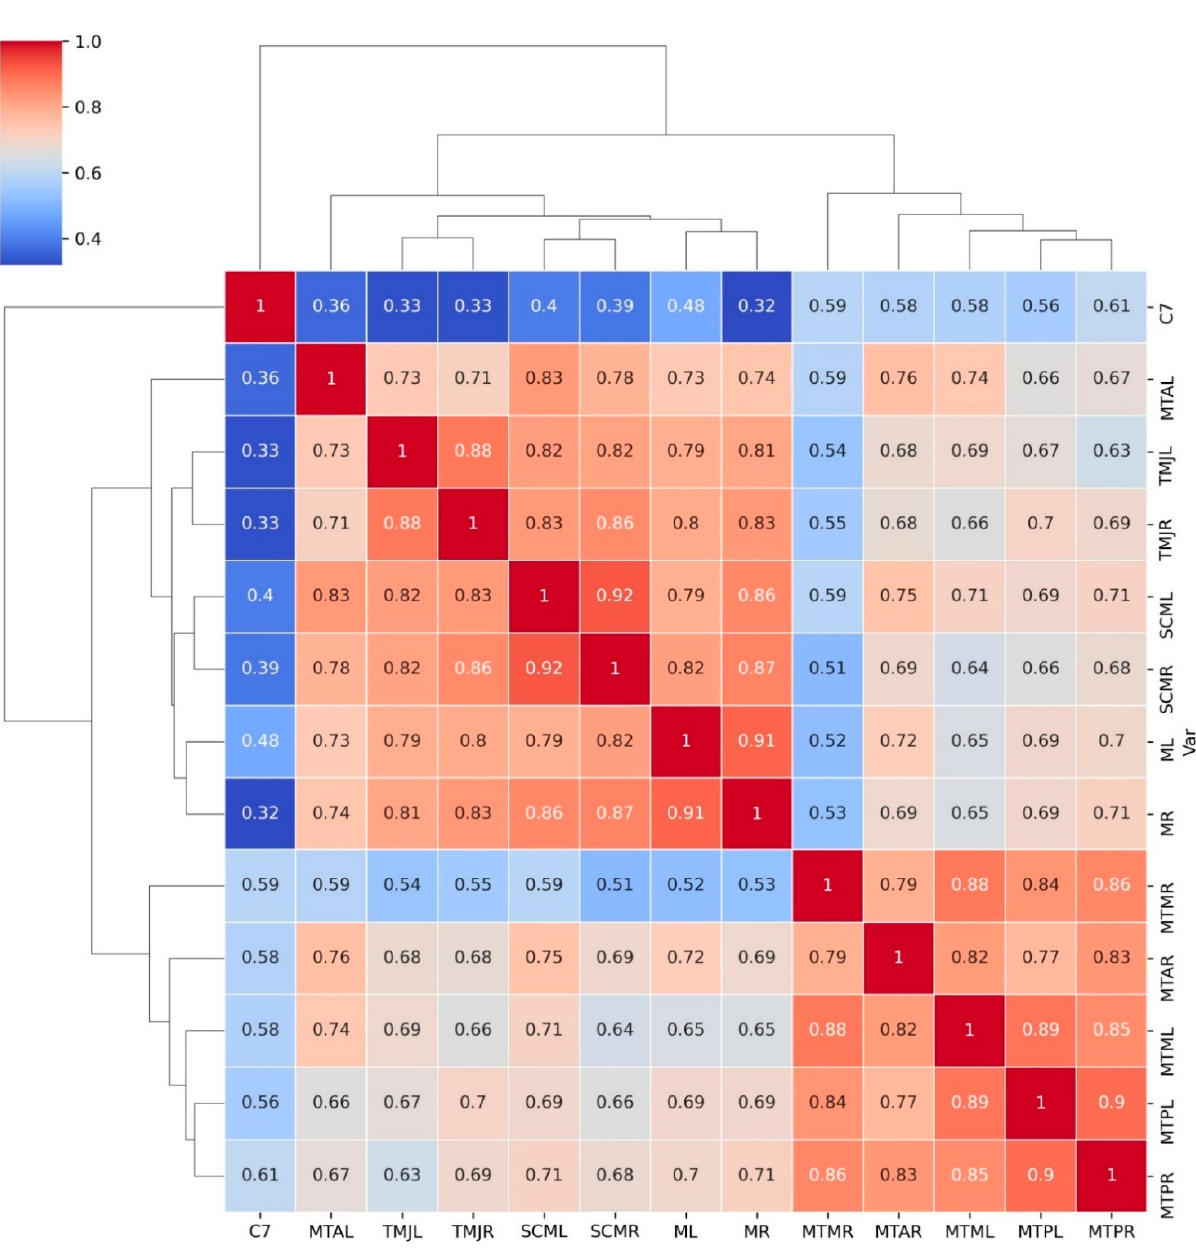
Figure 6. Graphical interpretation of correlations between the algometric measurements grouped using hierarchical clustering (Pearson’s correlation coefficients presented in squares). More detailed correlations may be found in Supplementary Material 1.